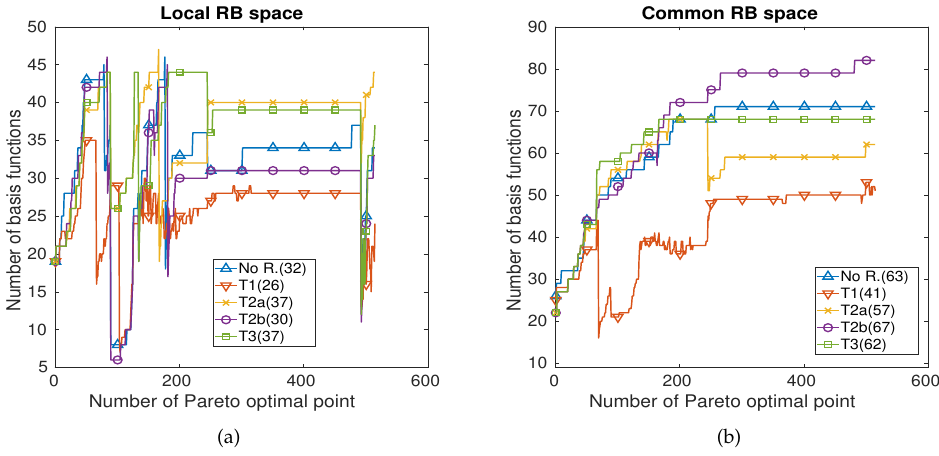
Figure 3. Number of basis functions used to compute each Pareto optimal point. ( a ) Local RB space. ( b ) Common RB space. In brackets: average number of basis